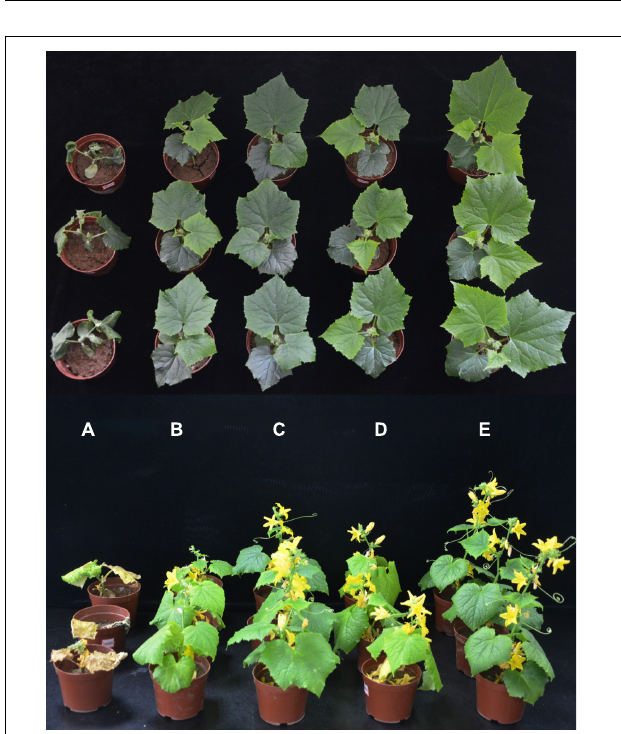
FIGURE 2 | Effect of strain YB-04 against Fusarium wilt and on growth-promotion of Cucumber Seedlings. (A) Only Foc inoculation; (B) Foc inoculation and hymexazol treatment; (C) inoculation of strain YB-04 and Foc ; (D) sterile distilled water; (E) only strain YB-04 inoculation.